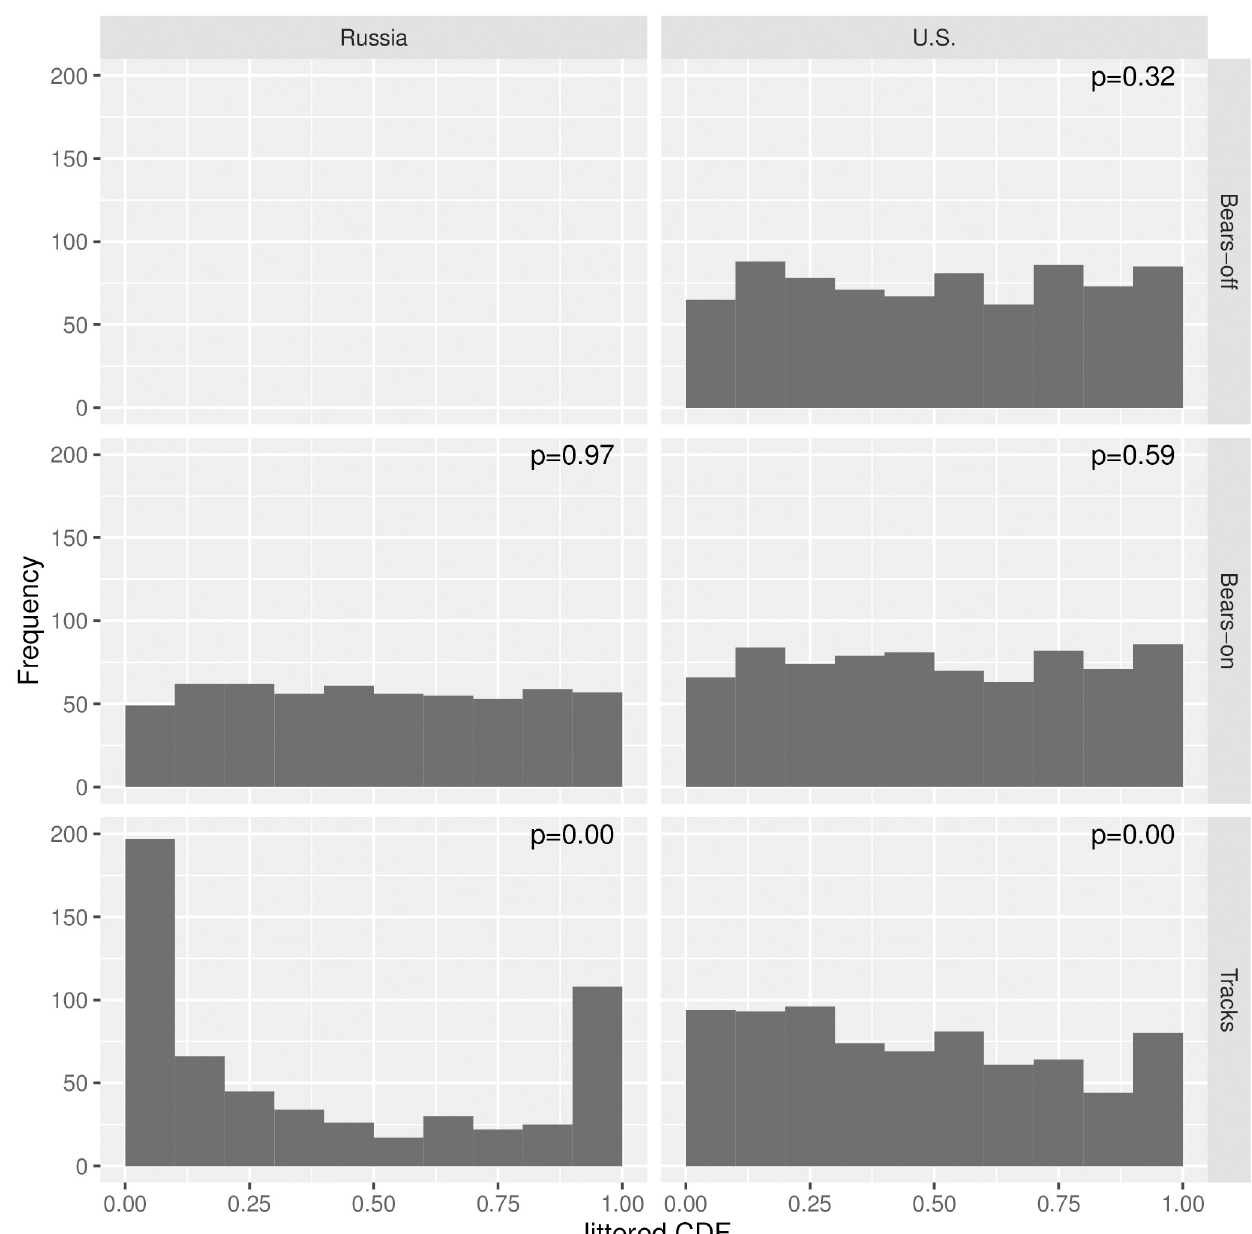
Fig 3. Goodness-of-fit diagnostics. Randomized quantile residuals (RQRs) for assessing goodness-of-fit for models fit to polar bear encounter data. RQRs should be uniformly distributed on (0,1) for a well-fitting model. Also presented are χ 2 test p-values to assess uniformity.